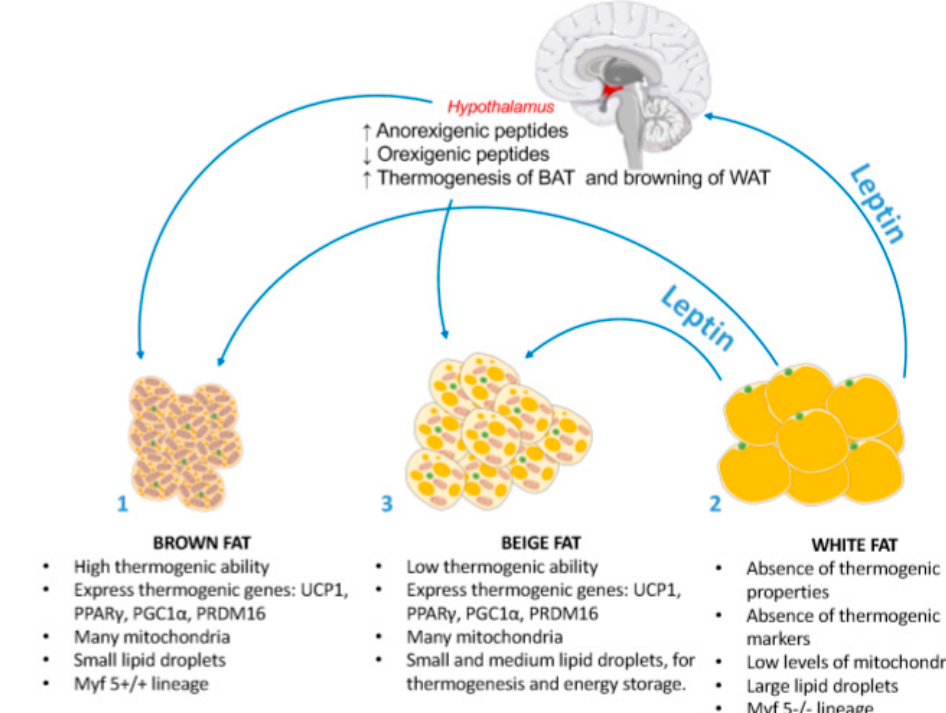
Figure 1. Thermogenic actions of brown, beige and white fat. (1) Brown adipose tissue (BAT) is responsible for heat production to maintain cell homeostasis through a process called thermogenesis. The anatomical features of brown adipocytes are adapted for thermogenesis: many mitochondria using the surrounding multi-locular lipid droplets as fuel to dissipate energy and produce heat. Furthermore, brown adipocytes express several thermogenic markers such as UCP1, PPAR γ , PGC1 α and PRDM16. Finally, brown adipocytes originate from myogenic (Myf5 +/+ ) lineage like myocytes. (2) On the other hand, white adipose tissue (WAT) is responsible for energy storage. In white adipocytes, fat accumulates in large lipid droplets (responsible of white adipocytes big diameter) that occupy the entire cytoplasm. White adipocytes do not carry any thermogenic functions nor thermogenic markers. (3) Beige fat has intermediate anatomical and functional characteristics between white and brown adipocytes. Thus, beige adipocytes emerge in white fat depots bearing thermogenic functions and expressing some thermogenic markers (at a lower proportion than BAT). Beige adipocytes can also store fat. Leptin is released by WAT and exerts its actions at central and peripheral levels. At a hypothalamic level, leptin favours anorexic effects through the overexpression of anorexigenic peptides and down-regulation orexigenic ones. Furthermore, leptin exerts its thermogenic actions in 2 different manners: (i) direct interactions with brown and beige adipocytes and (ii) through hypothalamic actions. UCP1, uncoupling protein 1; PPAR γ , peroxisome proliferator-activated receptor γ ; PGC1 α , proliferator-activated receptor-gamma coactivator 1 α ; PRDM16, PR domain containing 16.